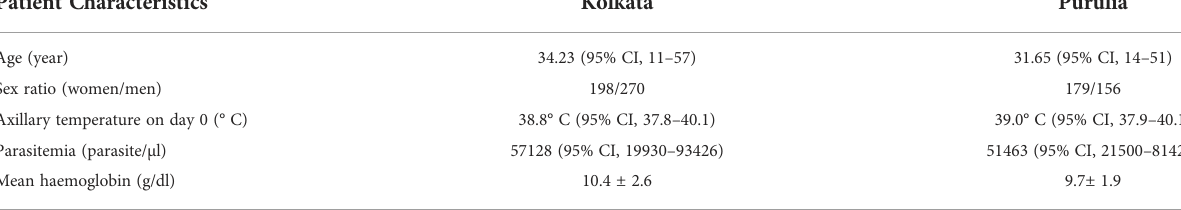
TABLE 1 Patient characteristics on enrolment of the experiment at different study sites. Patient